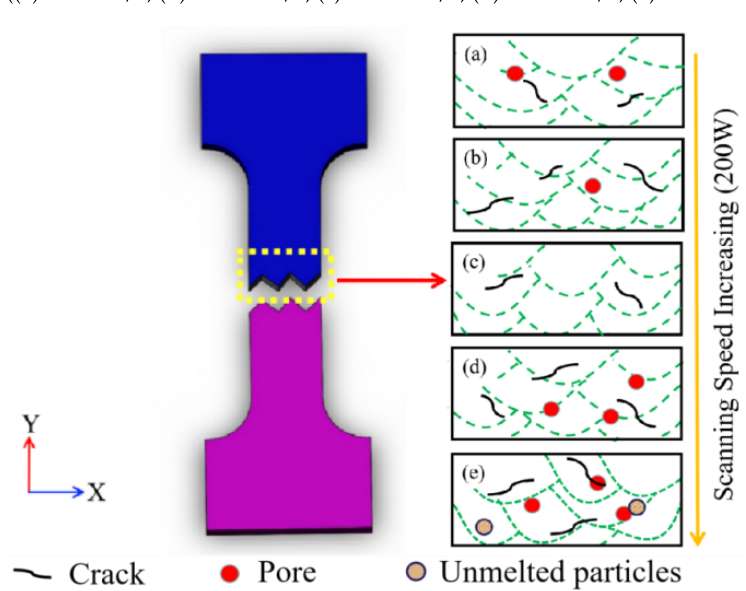
Figure 12. Defect distribution diagrams of tensile fractures’ transverse sections corresponding to different laser powers (( a ) 800 mm/s; ( b ) 1000 mm/s; ( c ) 1200 mm/s; ( d ) 1400 mm/s; ( e ) 1600 mm/s).